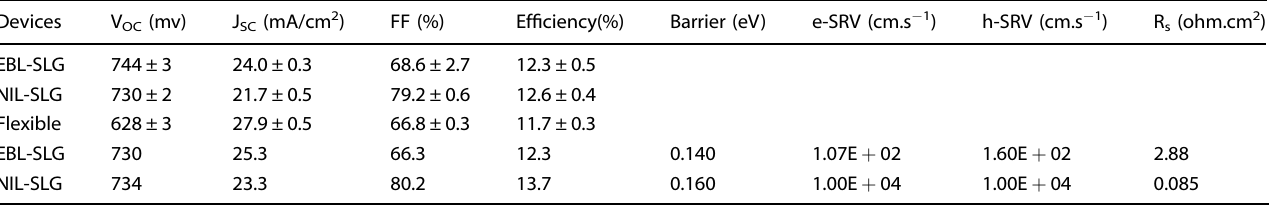
Table 1. The fi gures of merit average and standard deviation values for the fabricated devices and in dark blue the one obtained via SCAPS fi t for EBL-SLG and NIL-SLG, additionally the rear barrier for holes, and the SRV for electron and hole are also presented. Devices